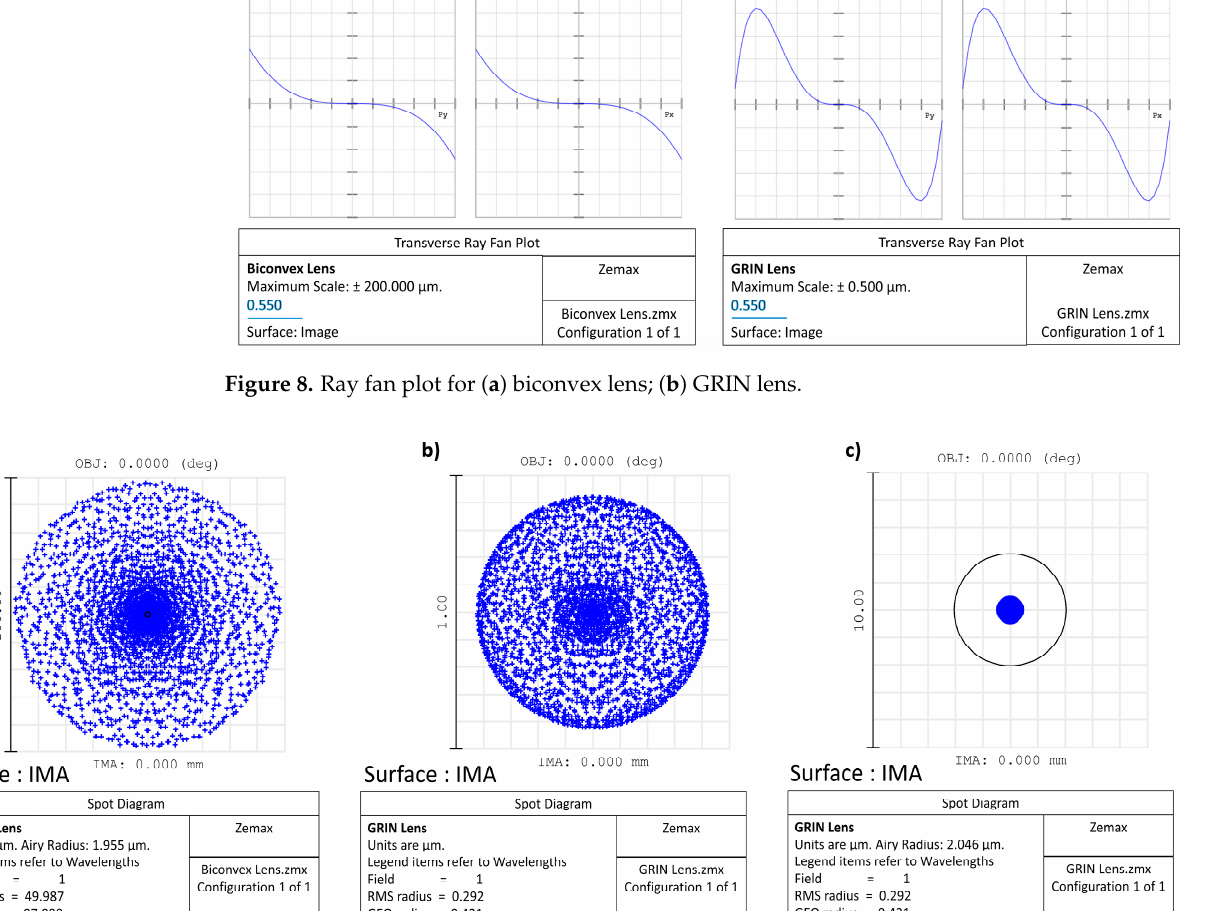
Figure 10. Transverse ray ( a ) and spot diagram ( b ) for the GRIN lens plotted with the same scale of the biconvex lens. 3. IOL-Based Materials Characterization and Tests of Entire IOLs IOL material properties are consistent within the classes of IOL materials considered. This suggests that the intraoperative and postoperative behaviour of an IOL is predictable and related to its composition, thus allowing surgeons to choose IOLs more appropriate for different surgical situations and individual patient characteristics. Several diagnostic techniques are suitable to analyse IOL-based materials and also the entire IOL system. Some of these experimental techniques are also adopted to visualize laser-induced defects in hydrophilic and hydrophobic acrylic IOLs in order to obtain qualitative information on the characteristics and also analyse differences regarding IOL material and water content without damaging the lens. In the next paragraphs, some data on physico-chemical and biological tests on pristine IOL materials and the manufactured IOL are reported.